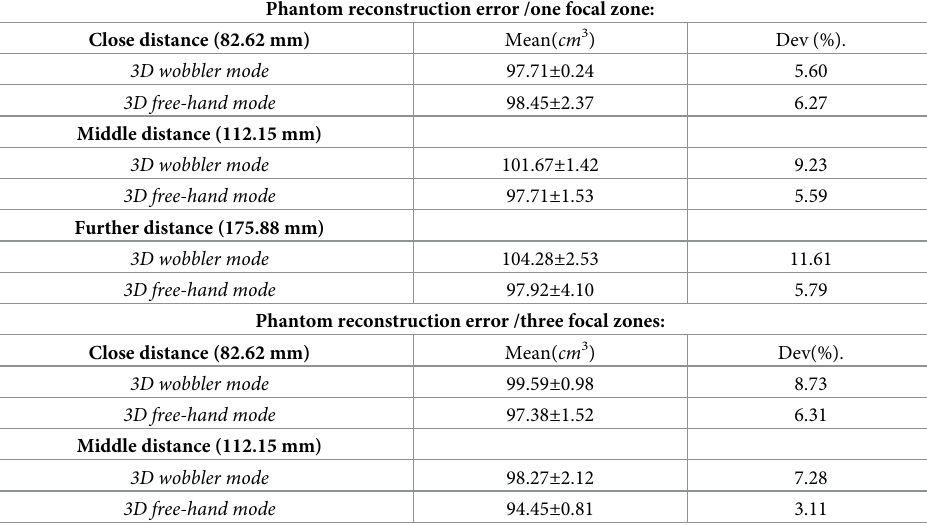
Table 3. Mean value and deviations of the egg phantom volumes for the two US modalities from the reference value of 91.6 cm 3 . With only one focal zone, the focus was placed manually at the level of the egg phantom center of mass. With three focal zones, the focus was set to cover entirely the width of the egg phantom. The distances listed refer to the ones between the bottom of the egg phantom surface and the transducer aperture. Phantom reconstruction error /one focal zone: Close distance (82.62